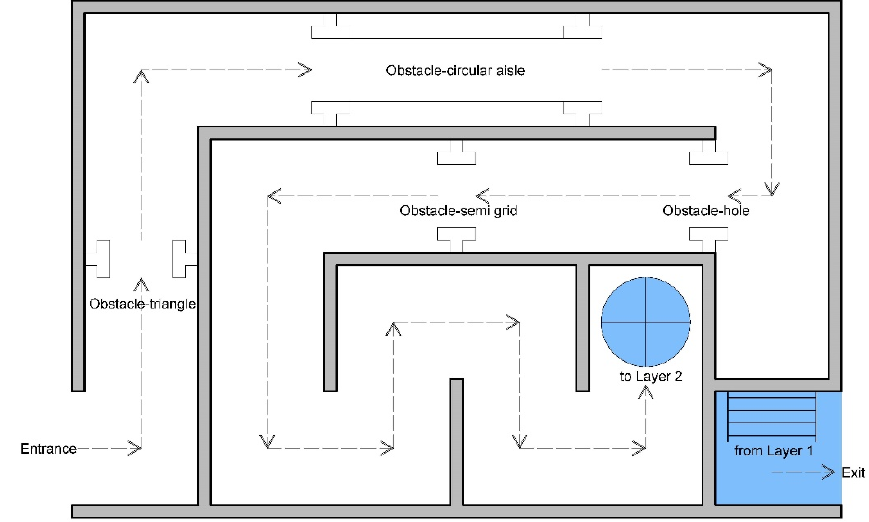
Figure 3. Floor plan for Layer 1.